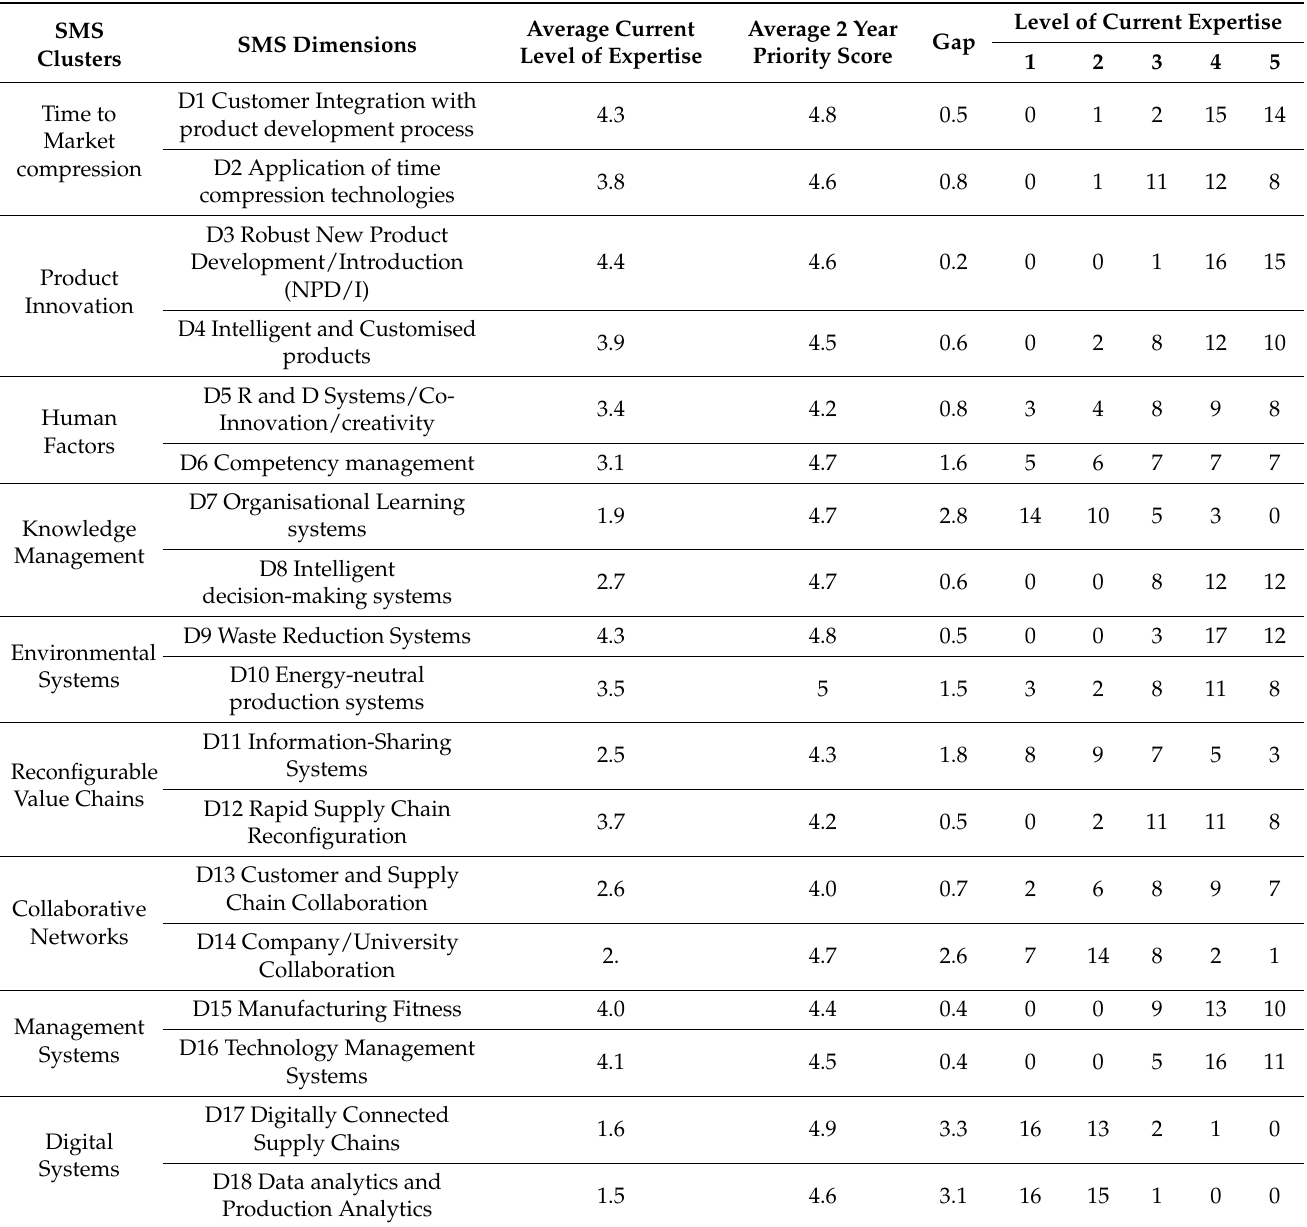
Table 3. The SMS